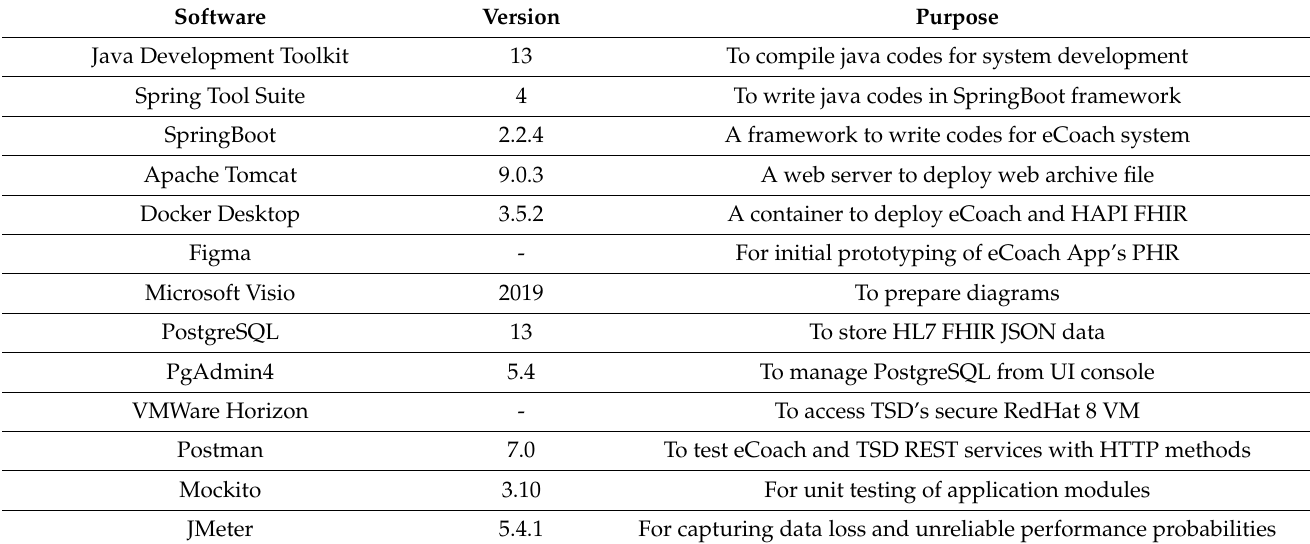
Table A3. Used software and their versions for this